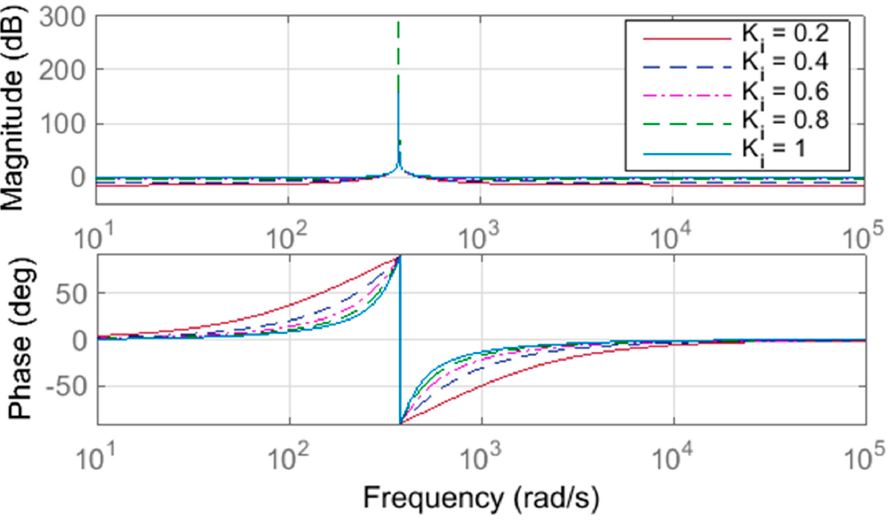
Figure 9. Frequency response of PR controller as a function of K i changes.